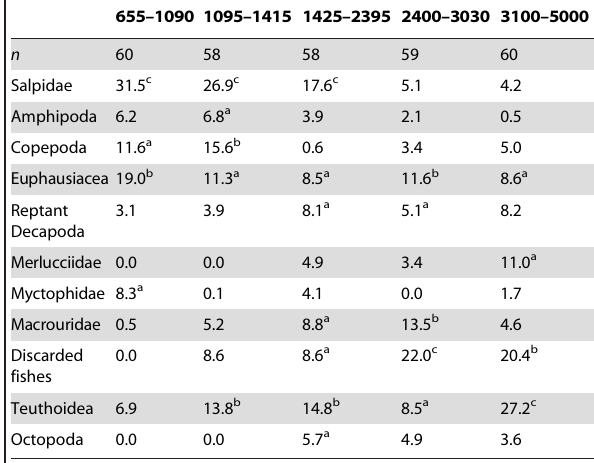
Table 4. Squalus acanthias diet by fish weight.